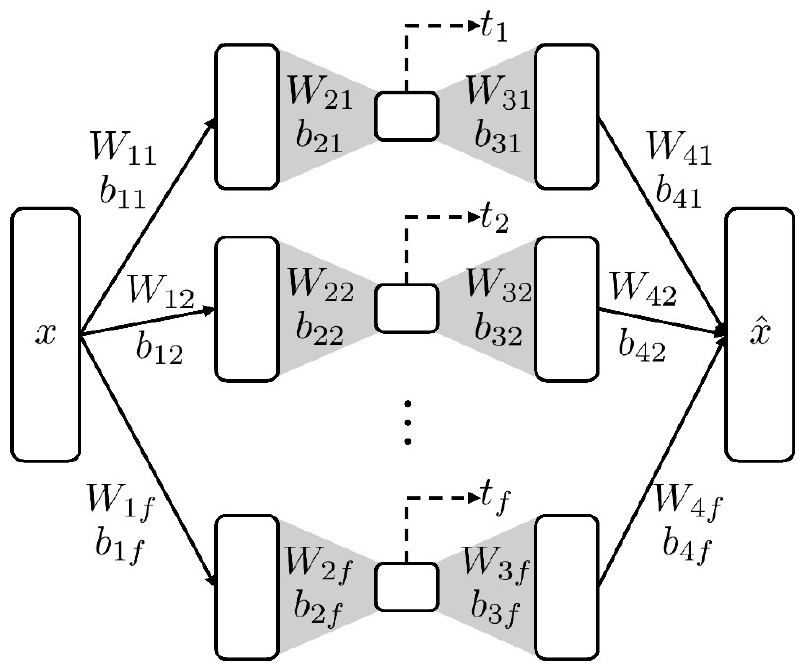
Figure 2. Alternative neural network architecture for parallel extraction of principal components.